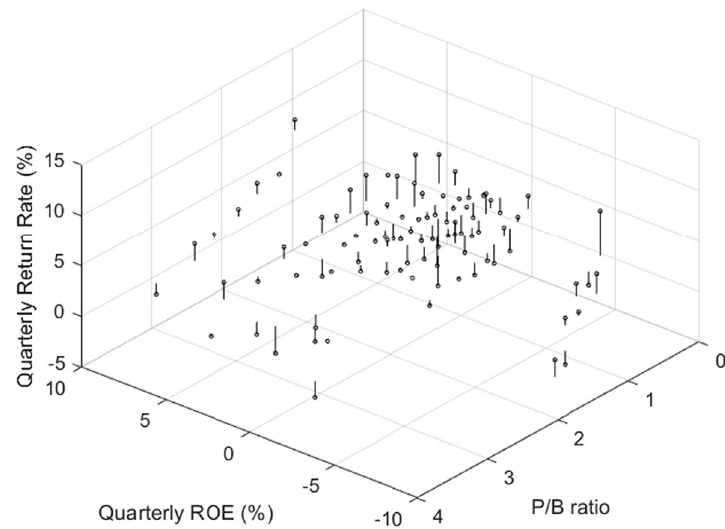
Fig. 38 3D scatter diagram of ROE (X), P/B (Y) in the t quarter, and the return rate in the t (circle: actual values, another end: predicted values): GVM